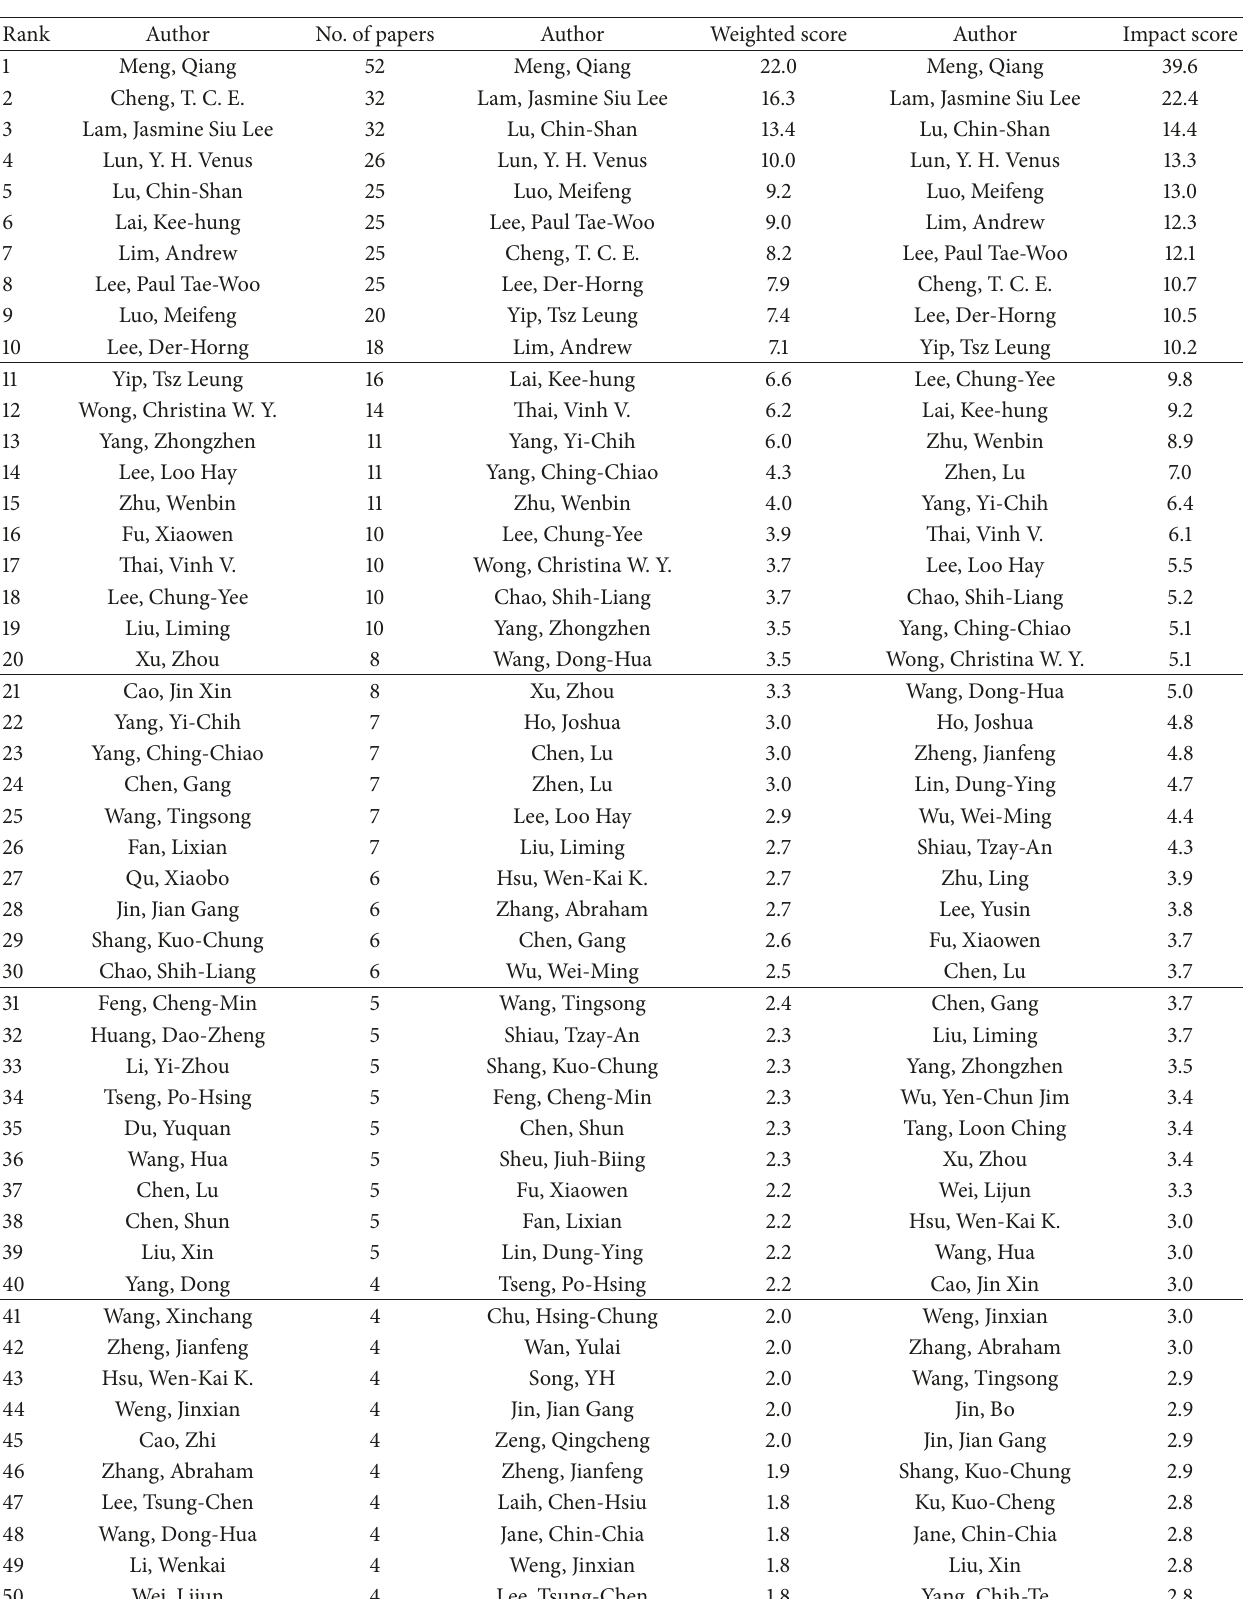
Table 1: Ranking by